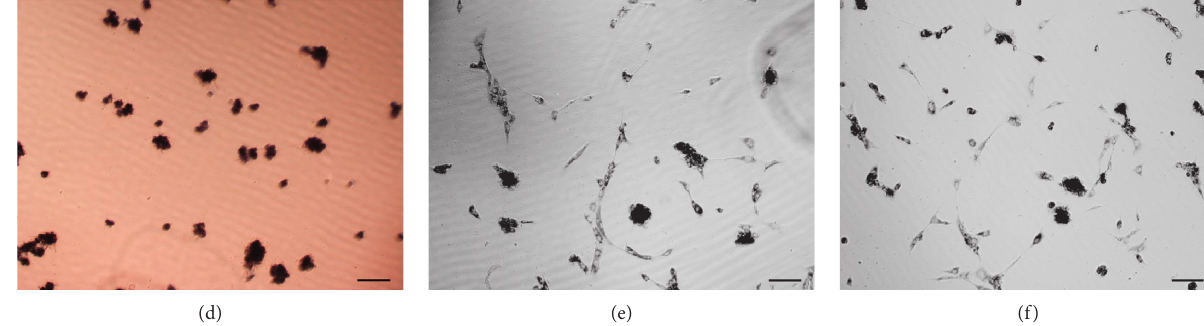
Figure 9: Optical images of HSF cells on CS/GO films (a, b, c) and CS films (d, e, f) after cultured 1d (a, d), 2d (b, e) and 3d (c, f). Cell seeding density is 1,6000 cells/well. Cells were stained by MTT. The scale is 100 μ